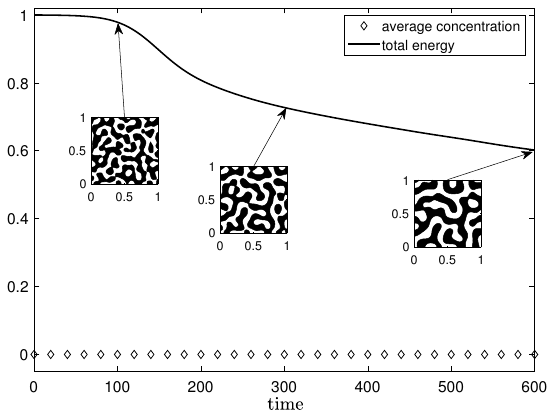
h ( φ n ) / h ( φ 0 ) (solid line) and average concentration E E